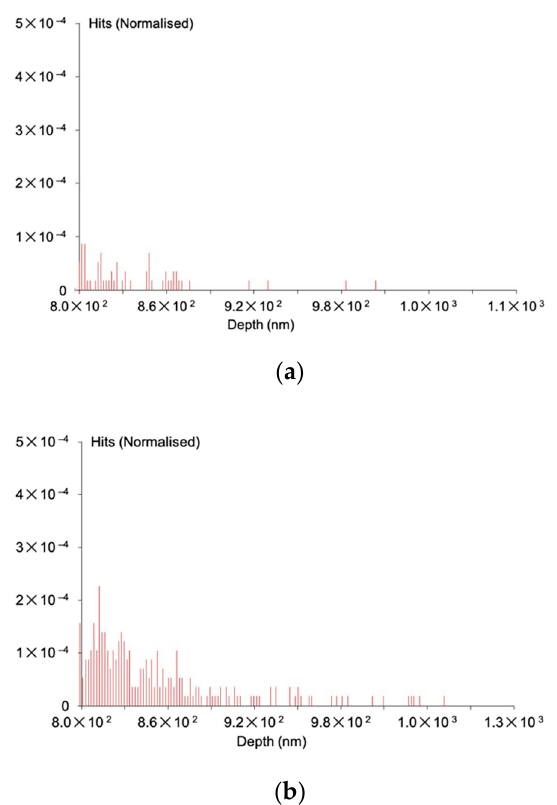
Figure 1. Backscattered electrons generated by the electron beam impacted on the nanoparticles at the acceleration voltages of ( a ) 8.1 and ( b ) 8.5 keV. These histograms are simulated by CASINO program [20].